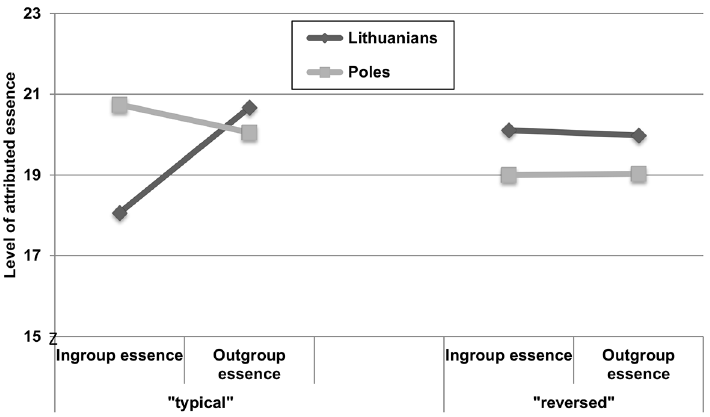
Figure 5. Interaction between ethnic group (Lithuanians vs. Poles) in two settings and ethnic target essence attribution (ingroup vs.